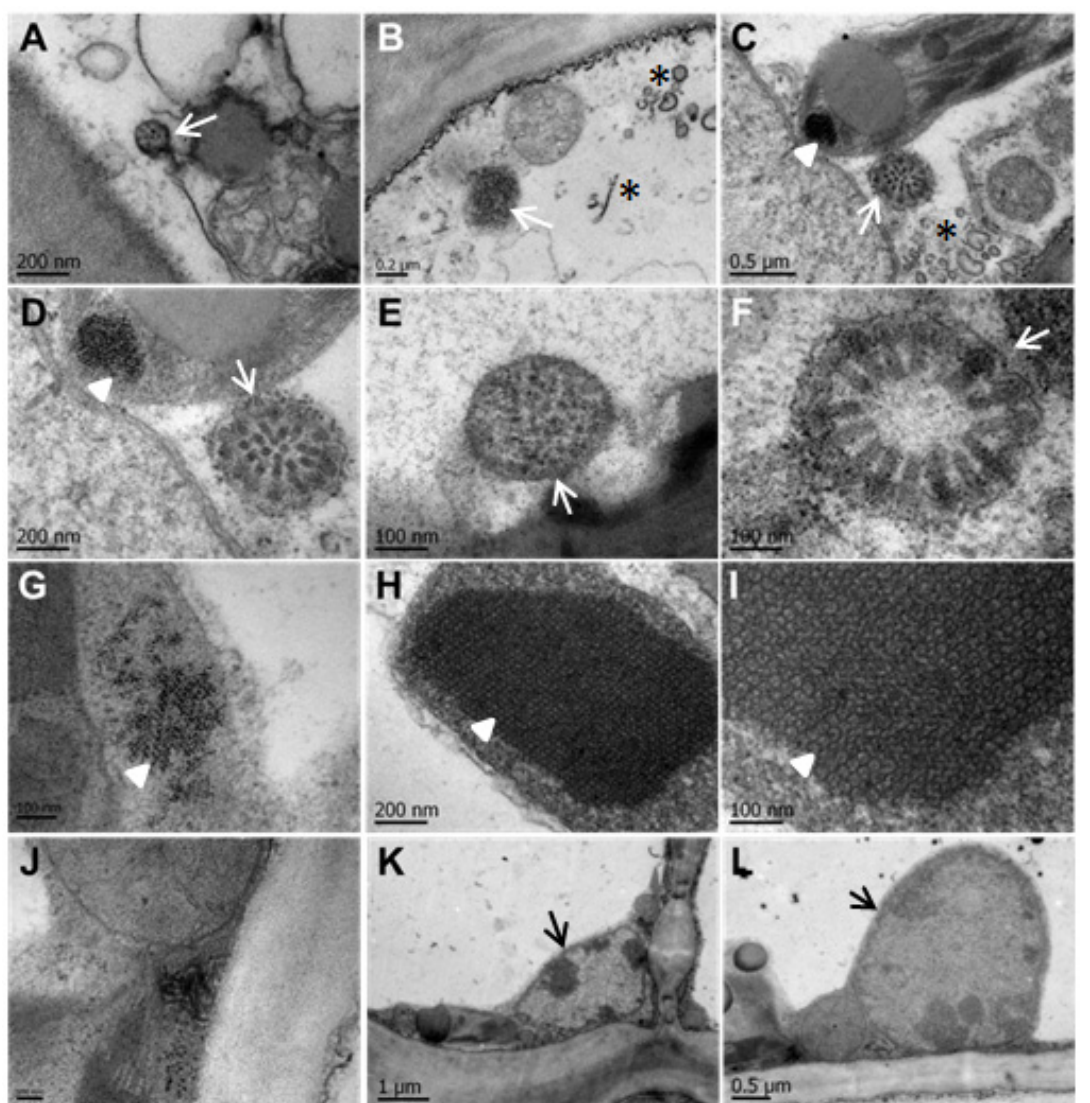
Figure 5. CNSV particles are located in the cytoplasm of infected cells. ( A – F ) Electron-dense viral particles are located in viroplasms within the cytoplasm of infected cells. Electron-dense structures with a membrane unit and average size of 120 to 475 nm ( A – F ) are indicated with arrows. A cross-section of a symmetric viroplasm, surrounded by host membrane, containing 16 rod-shaped viral structures, with a radial arrangement, is shown ( F ). Unassembled structures ( B , C ) are either linear or semicircular electron-dense filaments with an average length of 248 nm, indicated with asterisks. Electron-dense networks are present in the chloroplast of infected leaves ( C , D , G – I ; indicated with darts). ( J ) Membrane-associated viral particles in close proximity to the cell boundary. The nuclei of infected cells ( K , L ) without apparent viral structures. The bar size is indicated in each